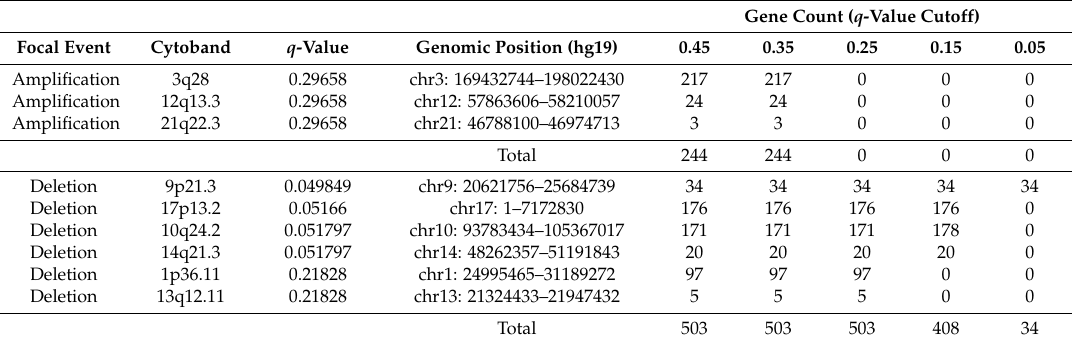
Table 7. List of regions and their associated genes located in the most common sections of recurrent DNA CNAs, derived from analysis conducted involving high grade samples (grades III and